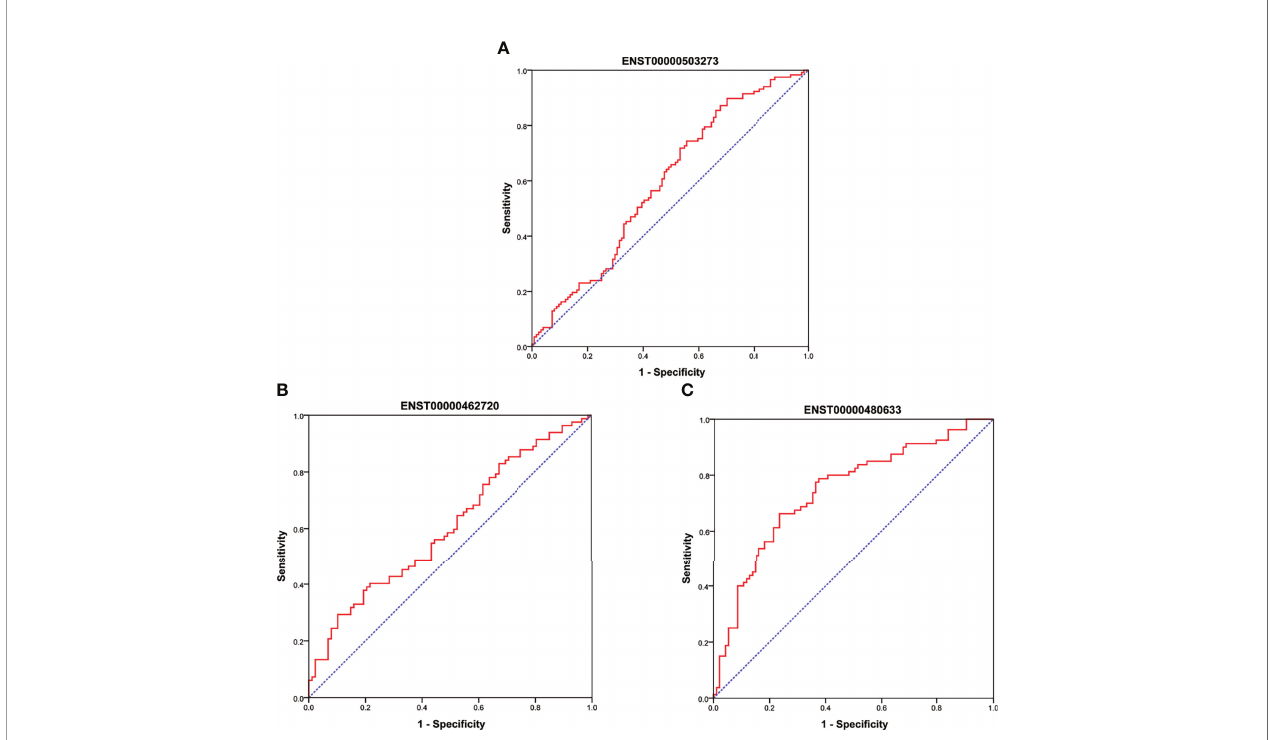
FIGURE 7 | (A) showed ROC curve for ENST00000503273 between T2DM and normal controls. (B, C) showed ROC curve for ENST00000462720 and ENST00000480633 between T2DM and prediabetes,